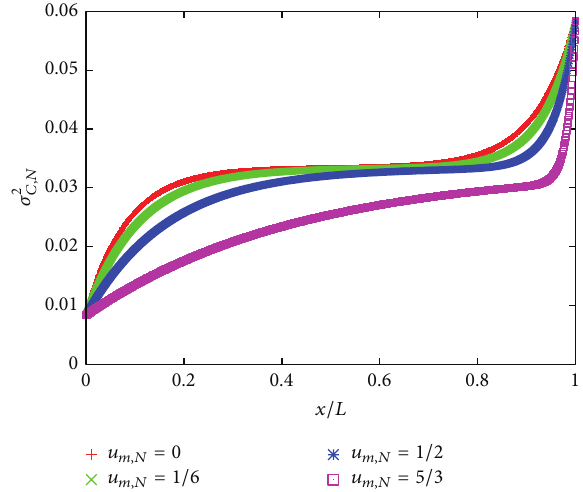
Figure 3: Reference nondimensional solution with sensitivity anal- ysis on the nondimensional mean velocity, which is alternatively equal to 0 (+), 1/6 ( × ), 1/2 ( ∗ ), and 5/3 ( ◻